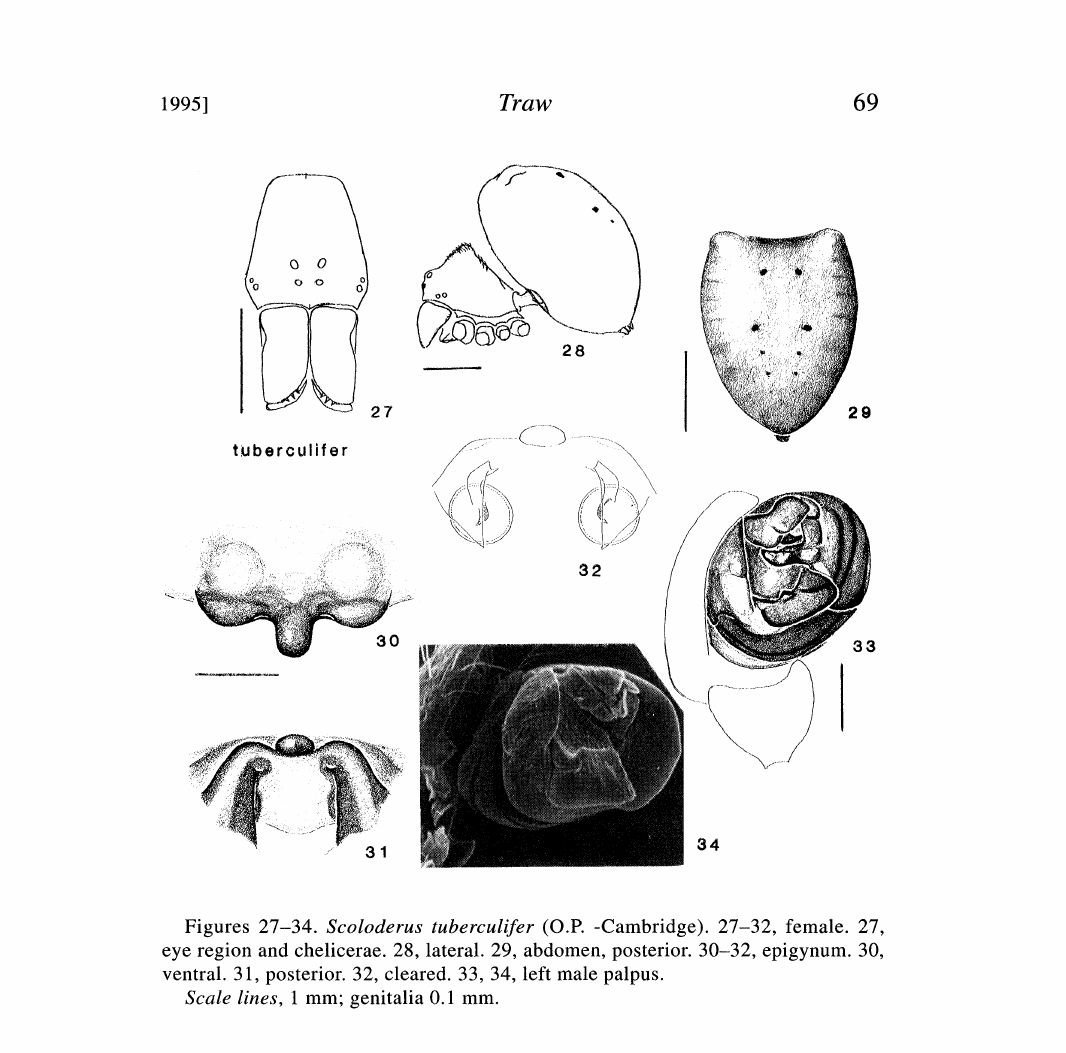
Figures 27-34. Scoloderus tuberculifer (O.P. -Cambridge). 27-32, female. 27, eye region and chelicerae. 28, lateral. 29, abdomen, posterior. 30--32, epigynum. 30, ventral. 31, posterior. 32, cleared. 33, 34, left male palpus. Scale lines, mm; genitalia 0.1